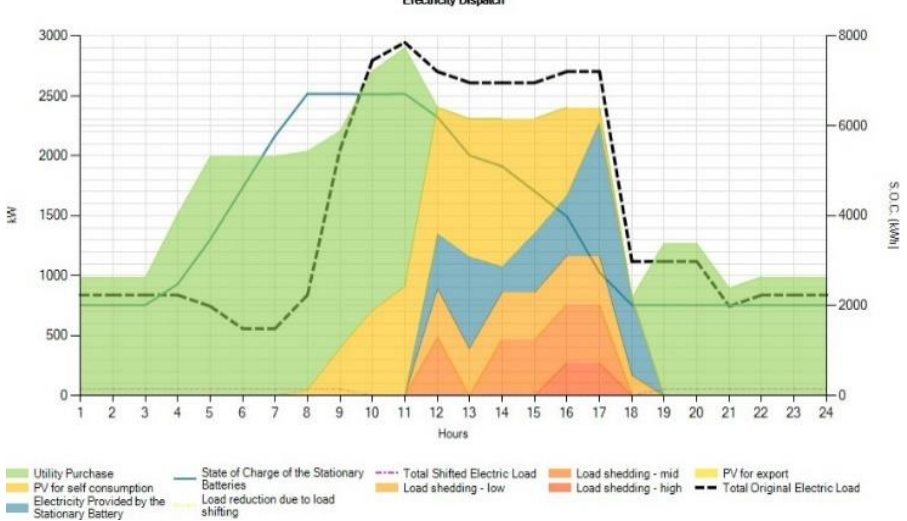
Figure 11. Electrical dispatch with DER, DR, &